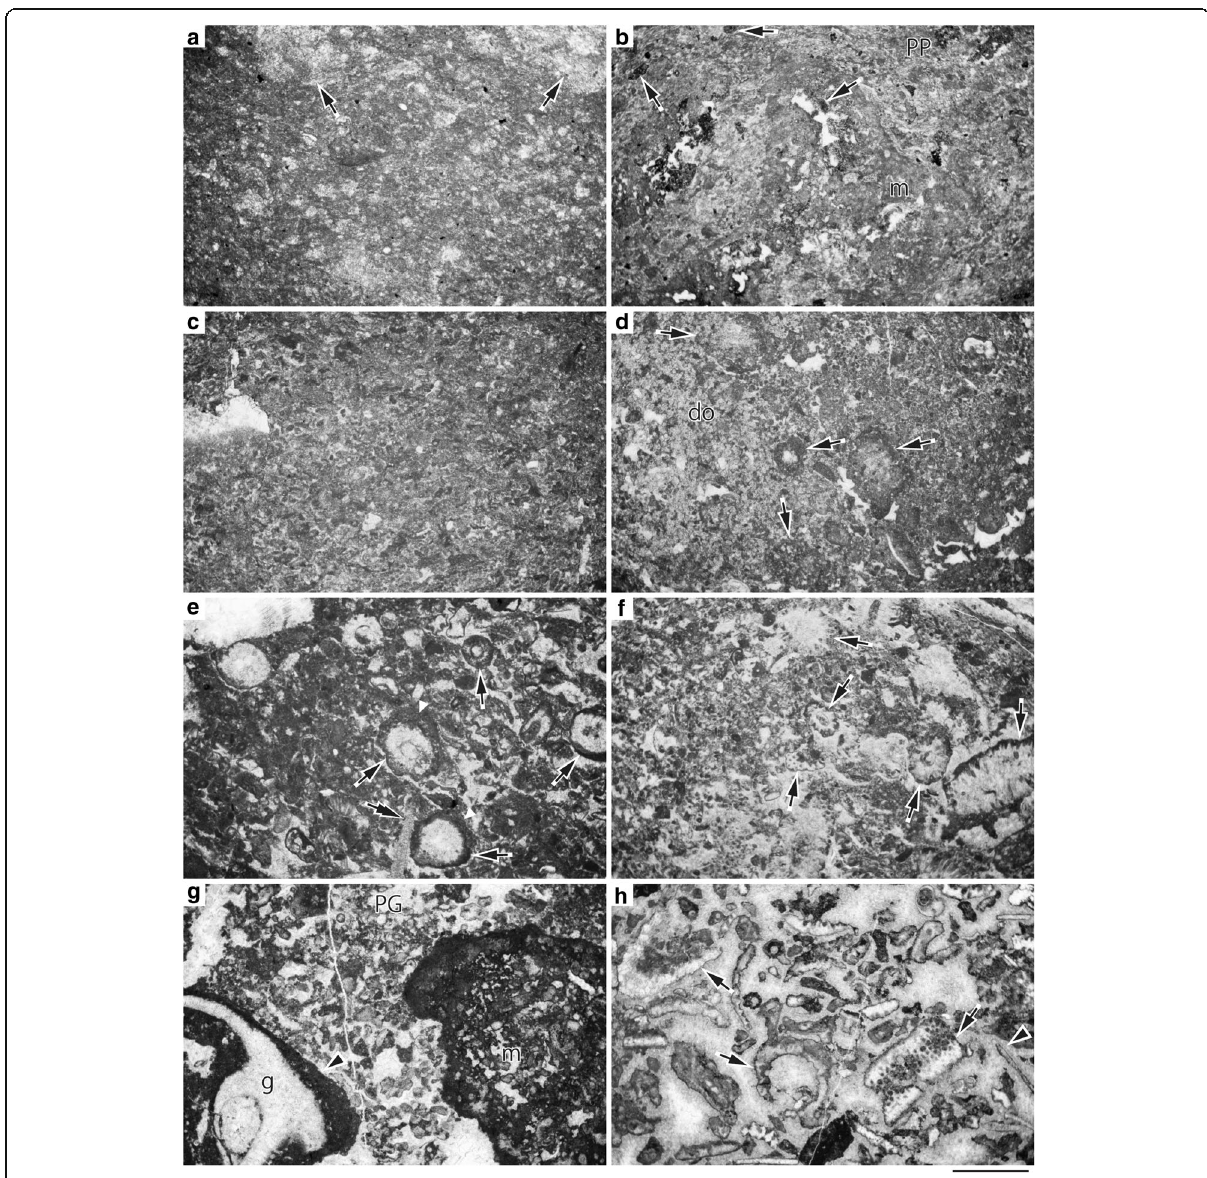
Fig. 4 Microfacies of the studied carbonates. a Sandy limestone with peloids, unit 1, 117.0 mdfrh in core no. 1, sample 1-140. Note bioturbation (arrows). b Microbialites (m) with a matrix of peloidal packstone (pp), unit 2, 105.5 mdfrh in core no. 1, sample 1-128. Note poorly laminated micritic mass binding peloids (arrows) derived from the peloidal packstone matrix. c Peloidal packstone, unit 2, 67.4 mdfrh in core no. 1, sample 1-86. d Dolomitized oncoidal floatstone, unit 3, 51.2 mdfrh in core no. 1, sample 1-67. Note oncoids (arrows) and dolomite rhombs (do). e Peloid bioclast packstone, unit 4, 156.5 mdfrh in core no. 4, sample 4-139. Note bioclasts of dasycladalean algae (arrows) and echinoid (double arrowhead) and thick micrite envelopes (white arrowheads). f Peloid bioclast packstone rich in dasycladalean algae (arrows), unit 5, 140.8 mdfrh in core no. 4, sample 4-123. g Microbialite (m) with a matrix of peloidal grainstone (PG), unit 5, 98.3 mdfrh in core no. 4, sample 4-86. Note a gastropod (g) with a thick micrite envelope (arrowhead) h Bioclastic grainstone, unit 6, 38.5 mdfrh, sample 4-35, in core no. 4. Note bioclasts of dasycladalean algae (arrows) and a thin-shelled bivalve (arrowhead). Scale bar,